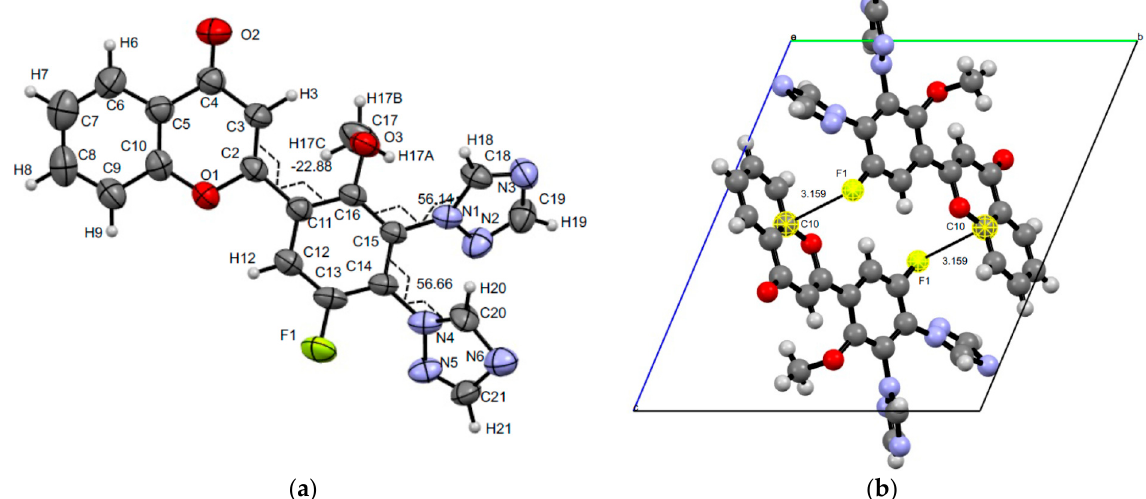
Figure 5. Molecular structure and selected torsions ( a ) and unit cell ( b ) of compound 19 with atoms represented as thermal ellipsoids of thermal vibrations with a 50% probability.